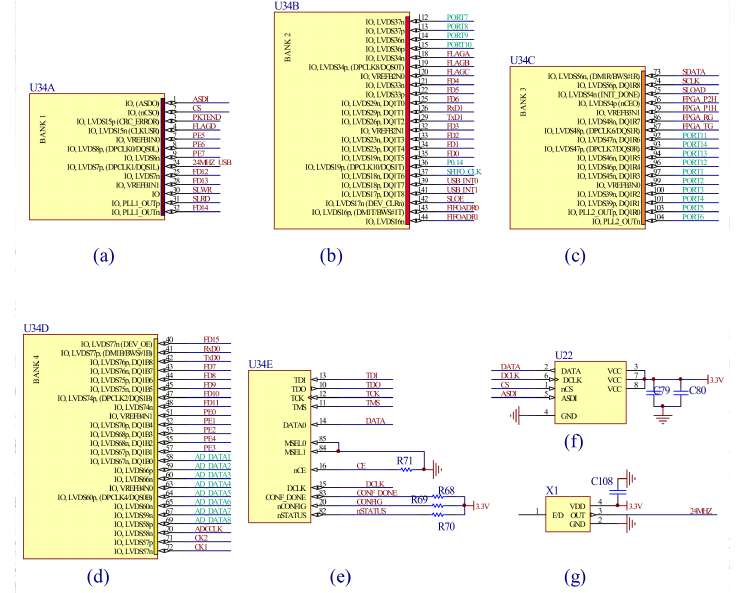
Figure 9. The field programmable gate array (FPGA) main control circuit: ( a ) BANK 1, ( b ) BANK 2, ( c ) BANK 3 and ( d ) BANK 4 of the FPGA; ( e ) the program download interface; ( f ) the memory chip, ( g ) the crystal oscillator